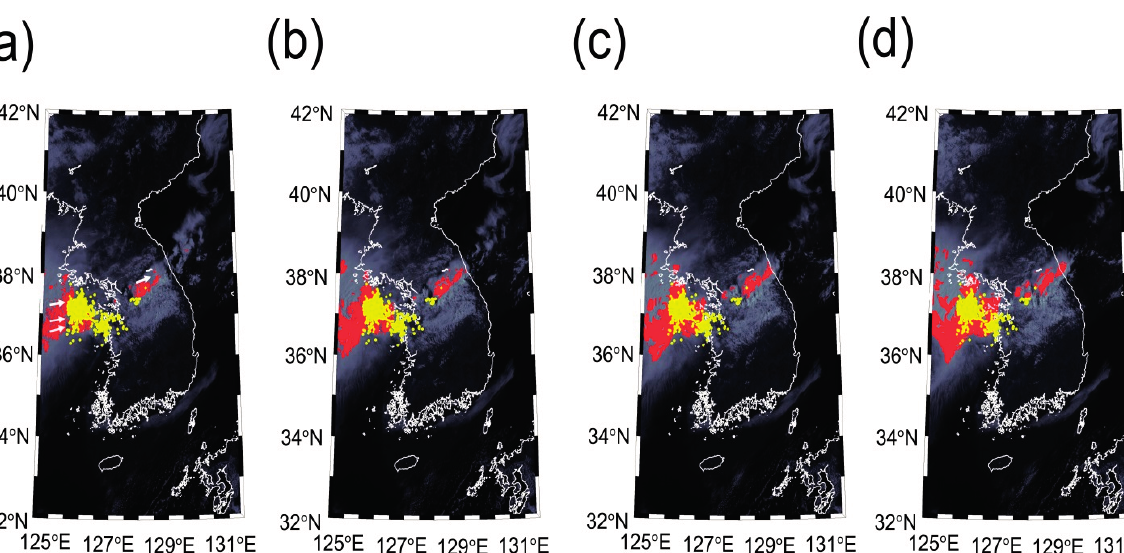
Figure 6. CI detection maps for the case in 2012 (CI by unstable atmosphere) generated from the RF model, overlaid with COMS MI IR1 images obtained ( a ) 60 min, ( b ) 45 min, ( c ) 30 min, and ( d ) 15 min before the image acquisition at the nearest time of the lightning occurrence. Red objects are the predicted CI and yellow dots represent the location of lightning occurrences. White arrows in (a) represent the movement directions of cloud objects.